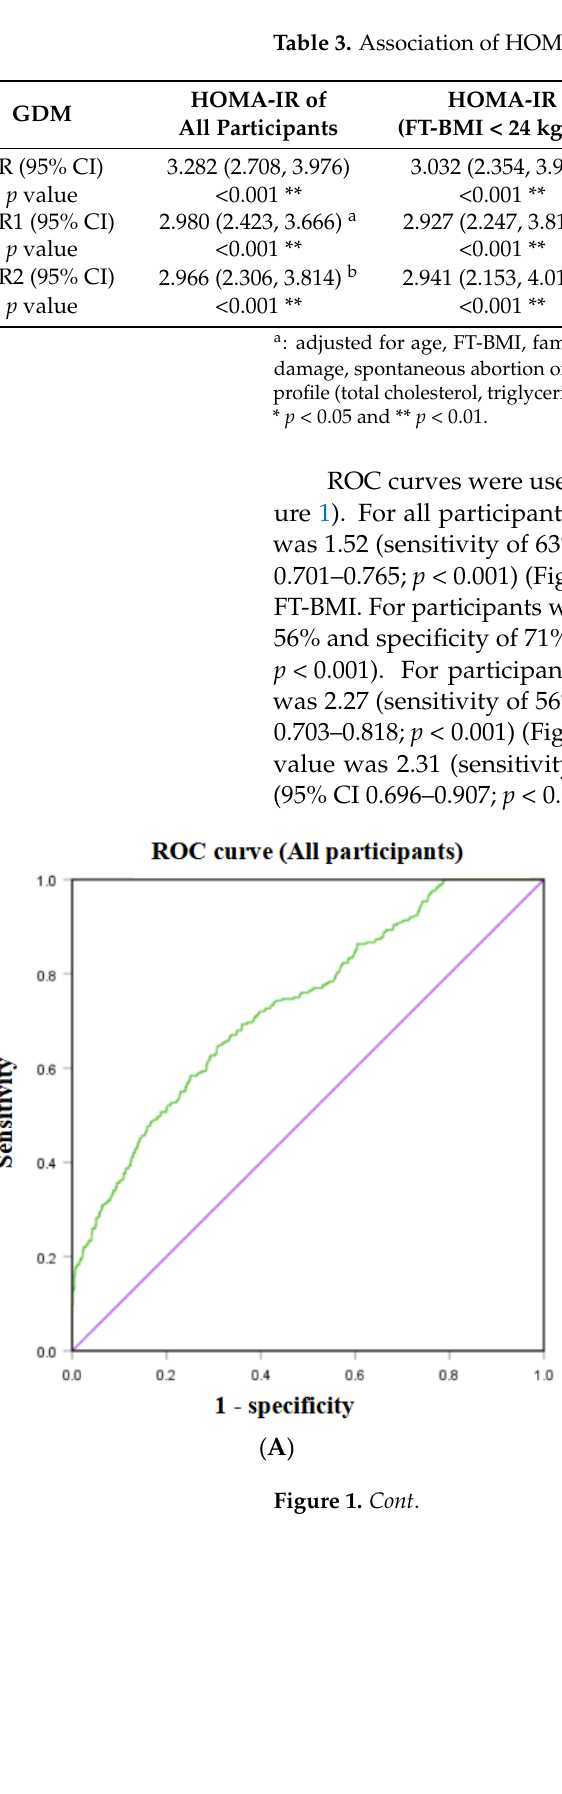
( D ) Figure 1. Ability of HOMA-IR in early pregnancy for predicting GDM in all participants ( A ), FT- BMI < 24 kg/m 2 subgroup ( B ), 24 ≤ FT-BMI < 28 kg/m 2 subgroup ( C ), and FT-BMI ≥ 28.0 kg/m 2 sub- group ( D ). 4. Discussion In this prospective cohort study, pregnant women were divided into different groups based on FT-BMI to identify the optimal cutoff values of HOMA-IR in early pregnancy for predicting GDM. To the best of our knowledge, this is the first study to explore the ability of HOMA-IR to predict GDM based on different FT-BMI values. Insulin resistance is defined as reduced responsiveness to high physiological insulin levels in insulin-targeting tissues, and it is considered an important pathogenesis of T2DM